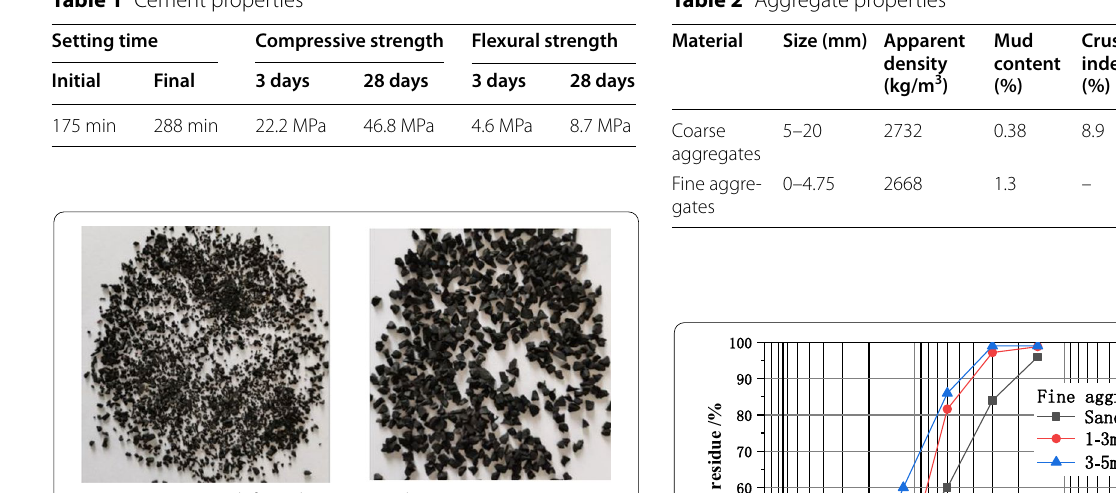
Fig. 1 RPs: 1–3 mm (left) and 3–5 mm (right)